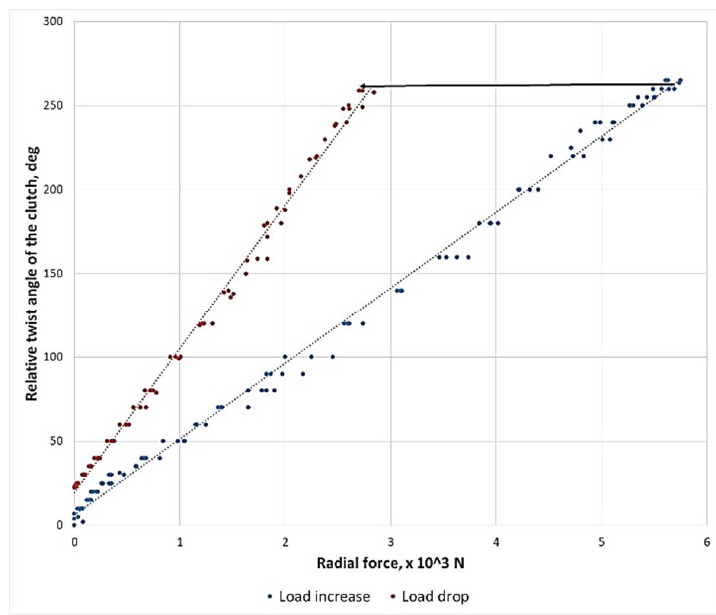
Figure 4. Static characteristics of the flexible metal clutch subject to testing.